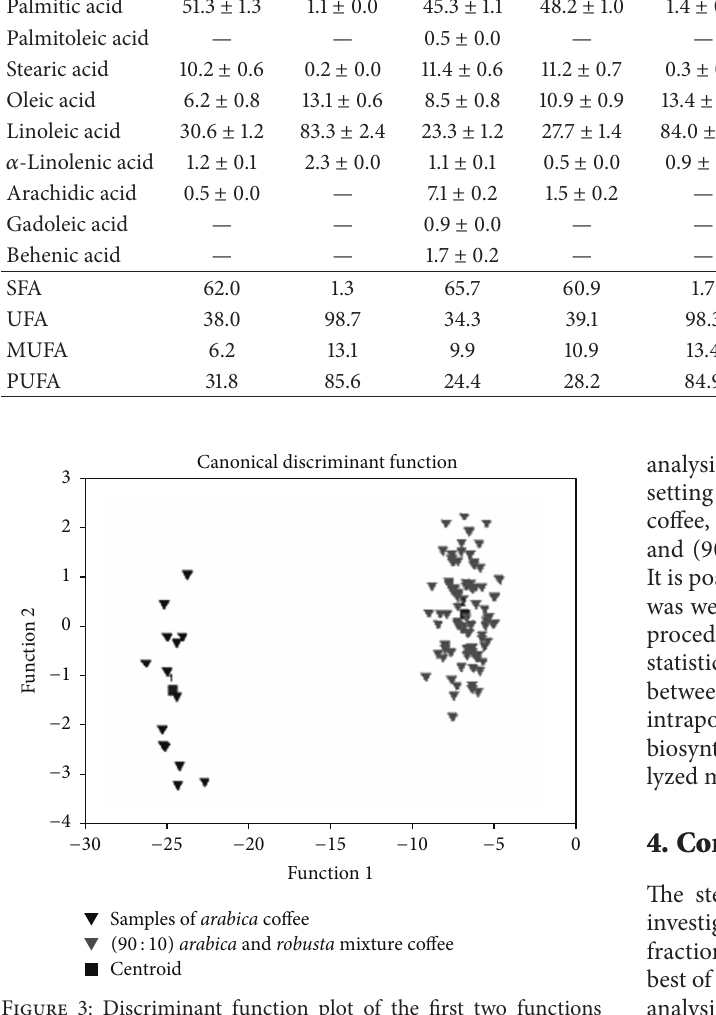
Figure 3: Discriminant function plot of the first two functions obtained from LDA analysis using TAG acidic